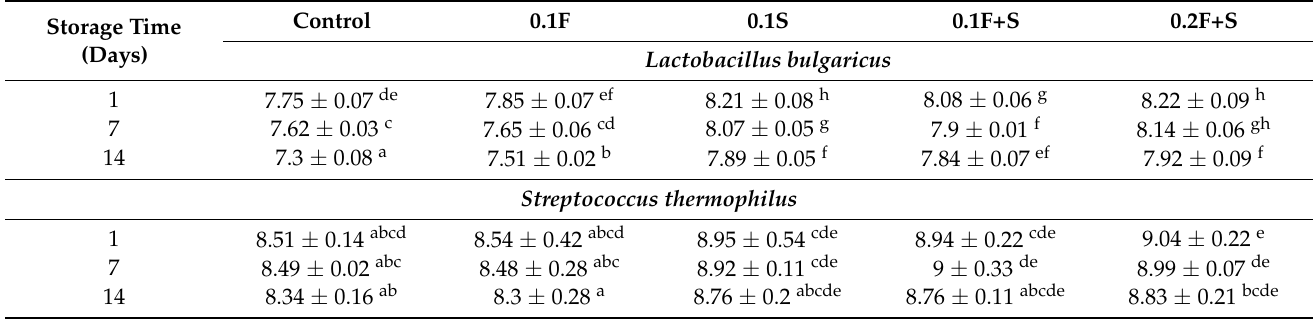
Table 6. Count of Lb. bulgaricus and S. thermophilus in yoghurt during storage (log